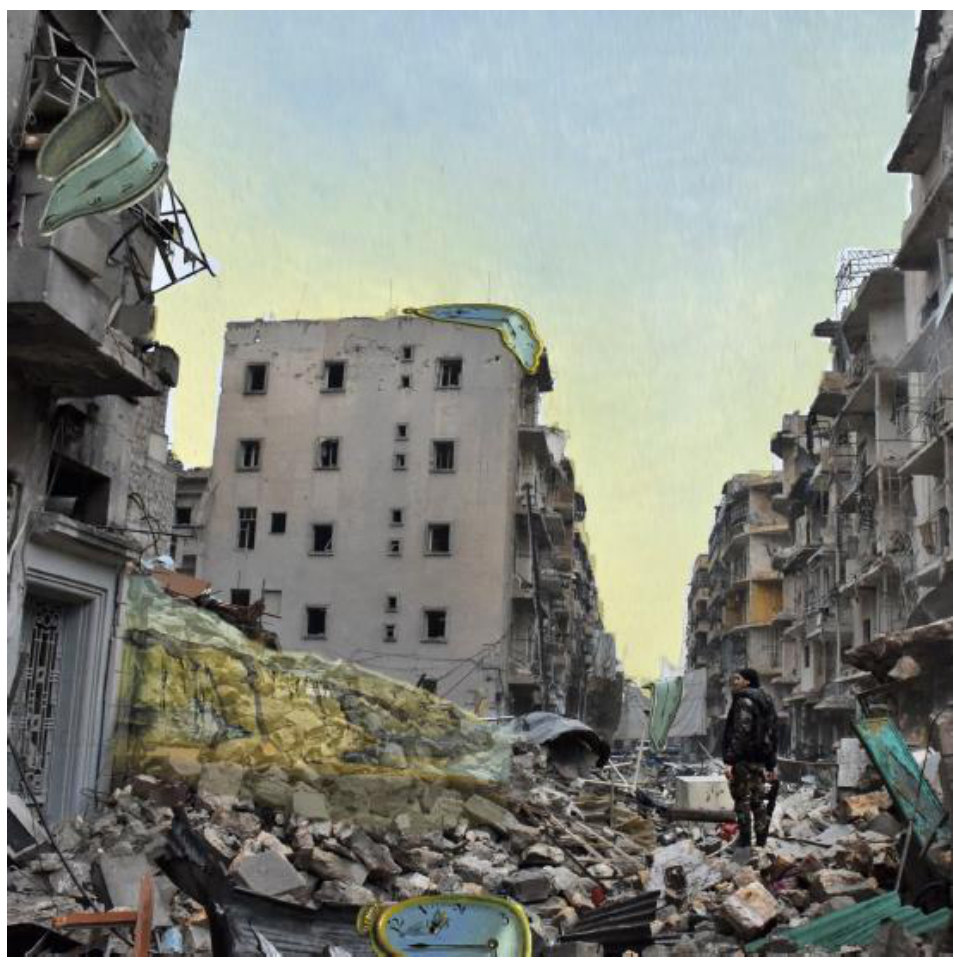
Meghan Kozal, Persistence of Memory , 2017, Graphic